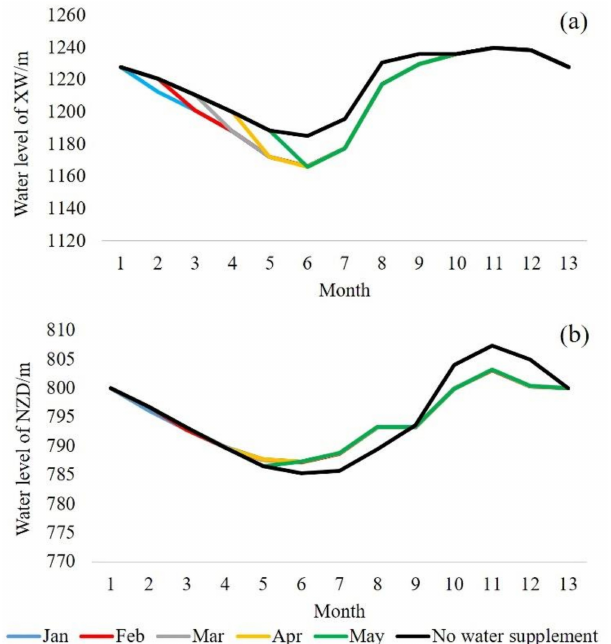
Figure 8. The water level processes of XW ( a ) and NZD ( b ) under the limit state of water supplement in 1997 (dry year, P =